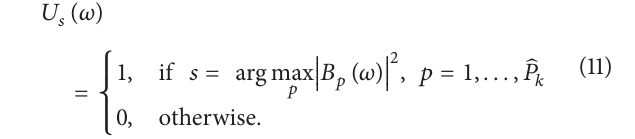
Figure 4: Power spectrum of the normalized far-field directivity pattern of an 8-element uniform circular array with 0.05 m radius, at a steering direction of 90 ∘